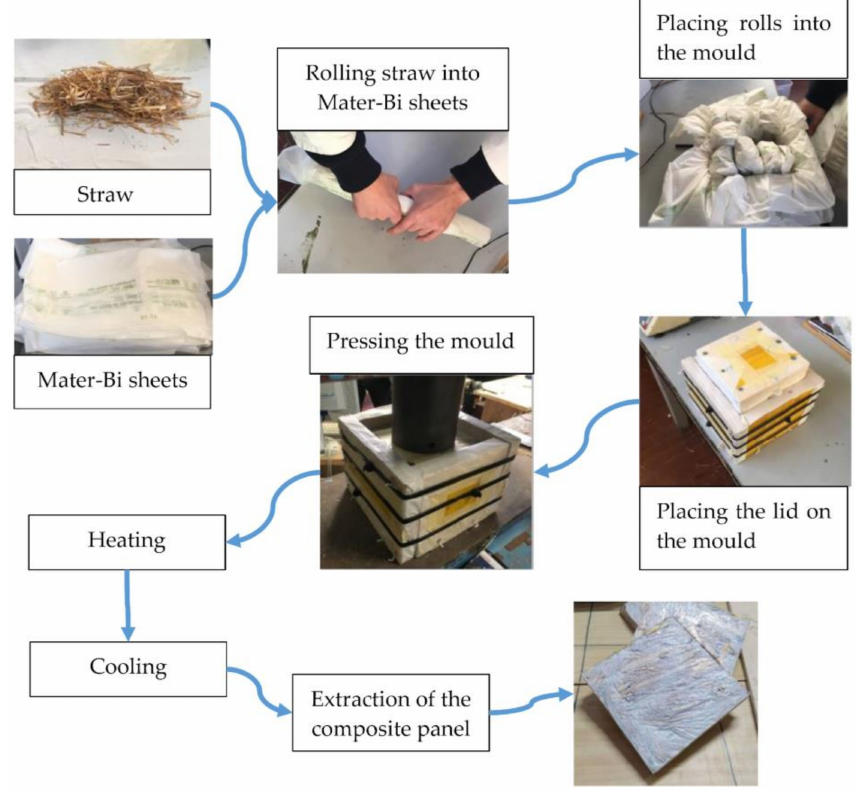
Figure 3. The NeoPalea forming procedure